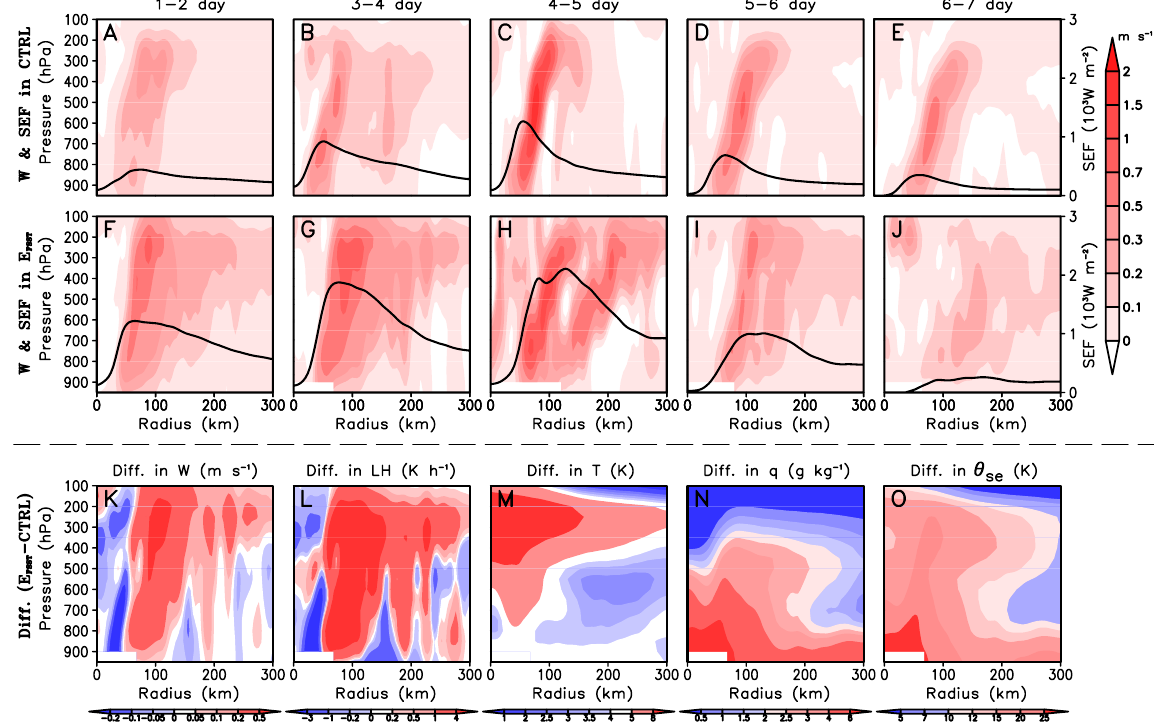
Figure 3. Impacts of SST warming on the time- and azimuthal-averaged TC structure for Bill (2009) case. ( a – j ) Radial - cross sections of the vertical velocity (shaded; m s − 1 ) and surface entropy flux (contours; 10 3 W m − 2 ) in the CTRL and E FSST at various one-day average periods; ( k – o ) Radial-cross sections of the 1–2-day averaged differences in the vertical velocity (m s − 1 ), latent heating (LH; K h − 1 ), temperature ( T ; K), water vapor mixing ratio ( q ; g kg − 1 ) and potential pseudo-equivalent temperature ( θ se ; K) between E FSST and CTRL